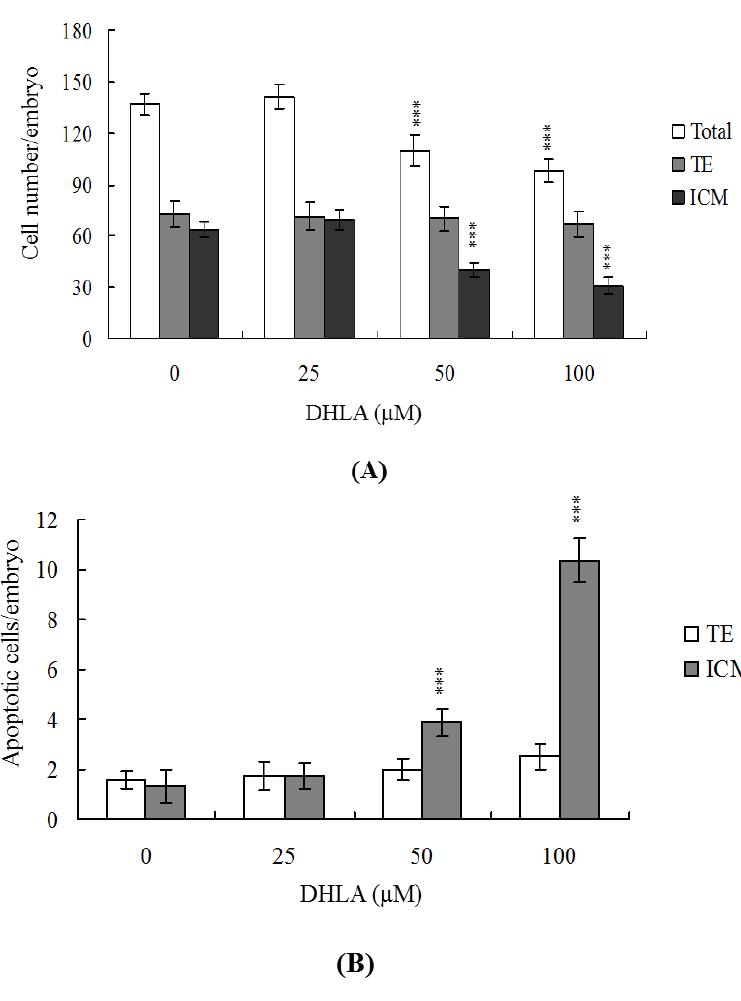
Figure 2. Effects of DHLA on blastocyst viability. Mouse blastocysts were treated with or without DHLA (25, 50 or 100 μM) for 24 h. ( A ) The total number of cells per blastocyst and cell numbers in the inner cell mass (ICM) and trophectoderm (TE) were counted; ( B ) The percentages of Annexin V-positive/PI-negative cells in blastocysts of each group were examined. Data are based on at least 200 blastocyst samples from each group. *** P < 0.001 versus the control